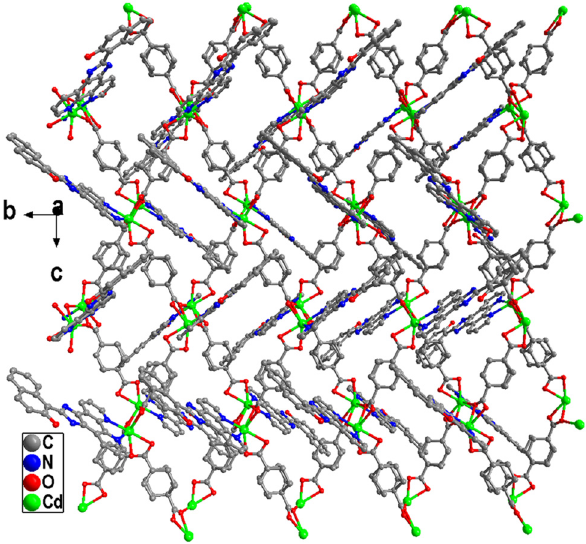
Figure 3: View of the 2D layer structure of 1 constructed by the 1,4 - chdc and L ligands.